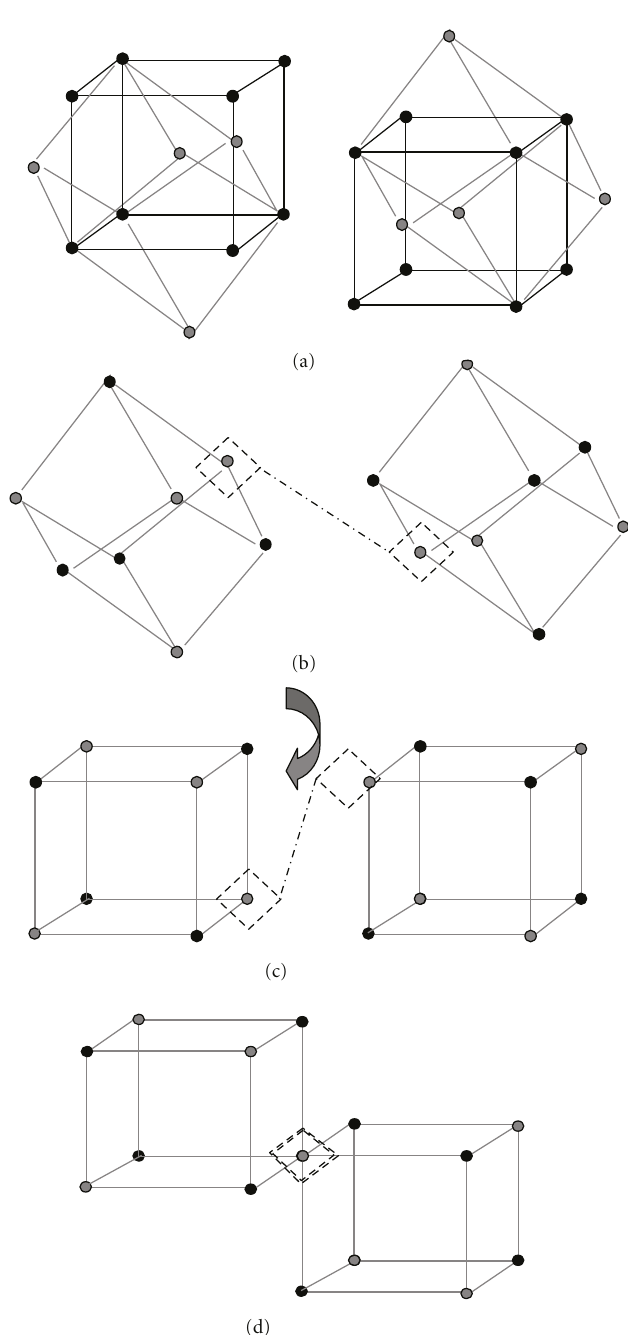
Figure 8: Body-centered cubic